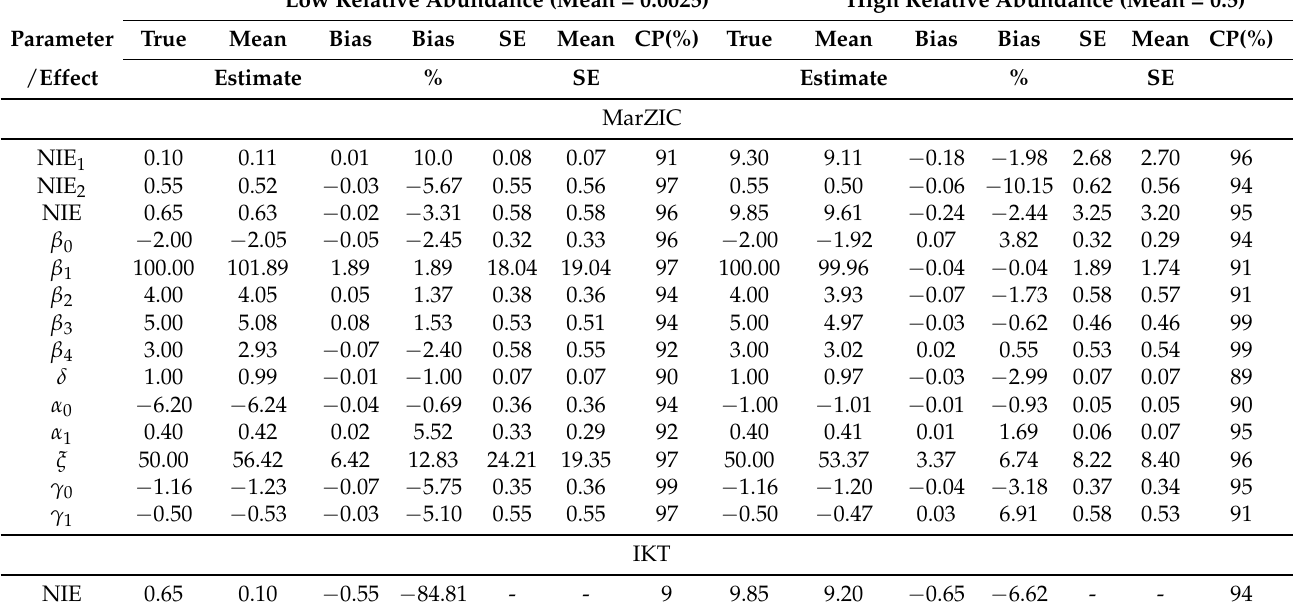
Table 1. Simulation results for comparison between MarZIC and IKT with sample size of n = 200. Bias, percentage of the bias, the empirical standard errors, the the mean of estimated standard errors and the empirical coverage probability of the 95% CI for each estimator is respectively reported under the columns Bias, Bias %, SE, Mean SE and CP(%). Mediation effects from the IKT approach are provided at the bottom part of the